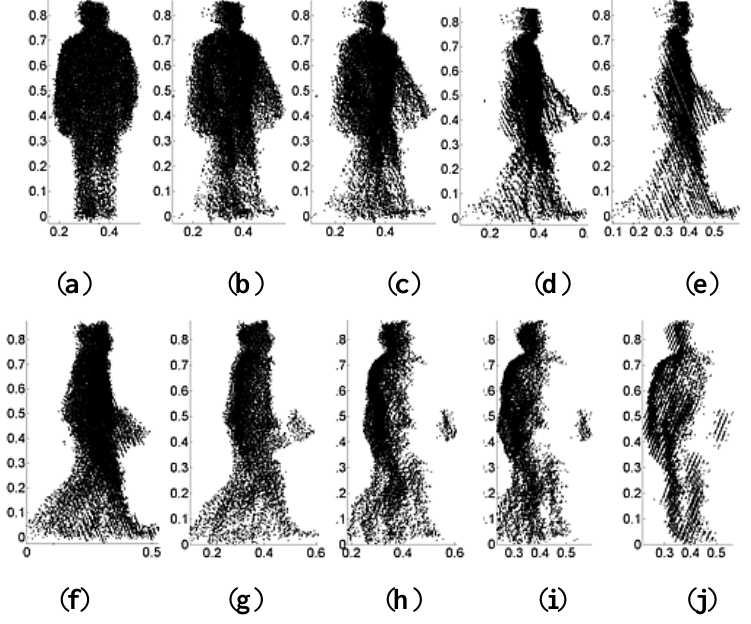
Figure 4. Self-occlusion caused by rotating 2.5D gait model: ( a – e ) 0° view rotated counterclockwise; and ( f – j ) 90° view rotated